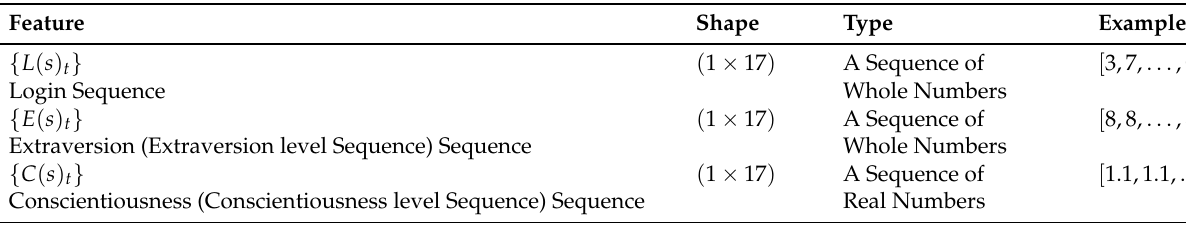
Table 9. B-PM training input and output